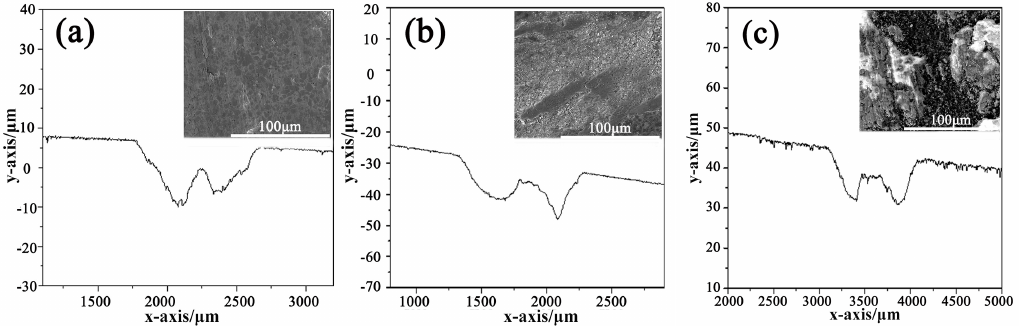
Figure 6. SEM micrographs of the worn surfaces of coatings ( a ) coating- A , ( b ) coating- B , and ( c ) coating- C .